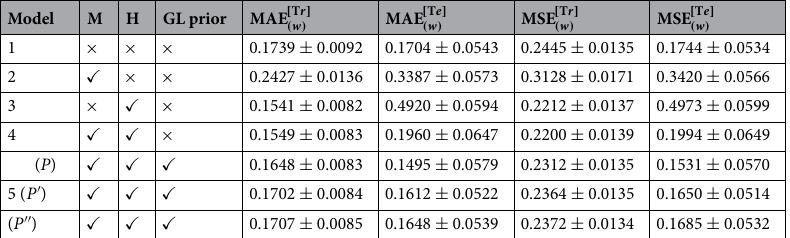
Results of parameter estimation. The mean and standard deviation of (cid:31) k ’s in Provinces 1 (in D 1 ), 10 (in D 2 ), and 22 (in D 3 ) are reported in Table 5. We can still see that Models 3–5 estimate the transmission parameters more accurately than Models 1 and 2 especially for Provinces 1 and 22. In addition, the estimates by Model 5 of (cid:31) k are closer than those by Model 4, due to the existence of the regularization term. The last three rows show the parameter estimates using Model 5 with three partitions P , P ′ , and P ′′ respec- tively. Recall that P is the ground truth underlying graph structure, and P ′ and P ′′ are mismatched partitions introduced in “Models to compare”. It can be seen that compared with the estimated parameters using Model 5 with P ′ that differs from P in the grouping of Provinces 1, 10, and 22, the estimates using Model 5 with P ′′ that differs from P in the grouping of Provinces 2, 11, and 23 are closer to the estimates using Model 5 with the ground truth partition P . Hence, the results imply that for the parameter inference of simulated data generated from a certain partition, the incorrect division causes more discrepancy in the mismatched regions when comparing the estimates using the ground truth partition. Further model evaluation. The mean and standard deviation of the weighted training and testing errors (formulas can be found in Sect. B of Supplementary Information, specifically in Eq. (S5)) are presented in Table 6. We see that Model 5 with µ ∗ = 10 1.8 achieves the minimum testing errors among all the models, and hence have the best generalization performance. The last three rows show the comparison of errors for Model 5 with three partitions P , P ′ , and P ′′ respectively. We may see that the testing errors of Model 5 with the incorrect partitions are basically the same and larger than those with the ground truth partitions. Nevertheless, these errors are still smaller than the other baseline models. Therefore, the incorrect division might worsen the generalization performance of Model 5; however, when the division does not deviate from the ground truth much, it still behaves better than Models 1–4 with uniform prior. Moreover, as shown in Table 6, both Model 2, which allows transportation but not heterogeneity, and Model 3, that introduces heterogeneity but no transportation, behave worse than the baseline Model 1. Model 2 having more significant testing errors is due to the same reason as the case of four provinces, as has been analyzed in